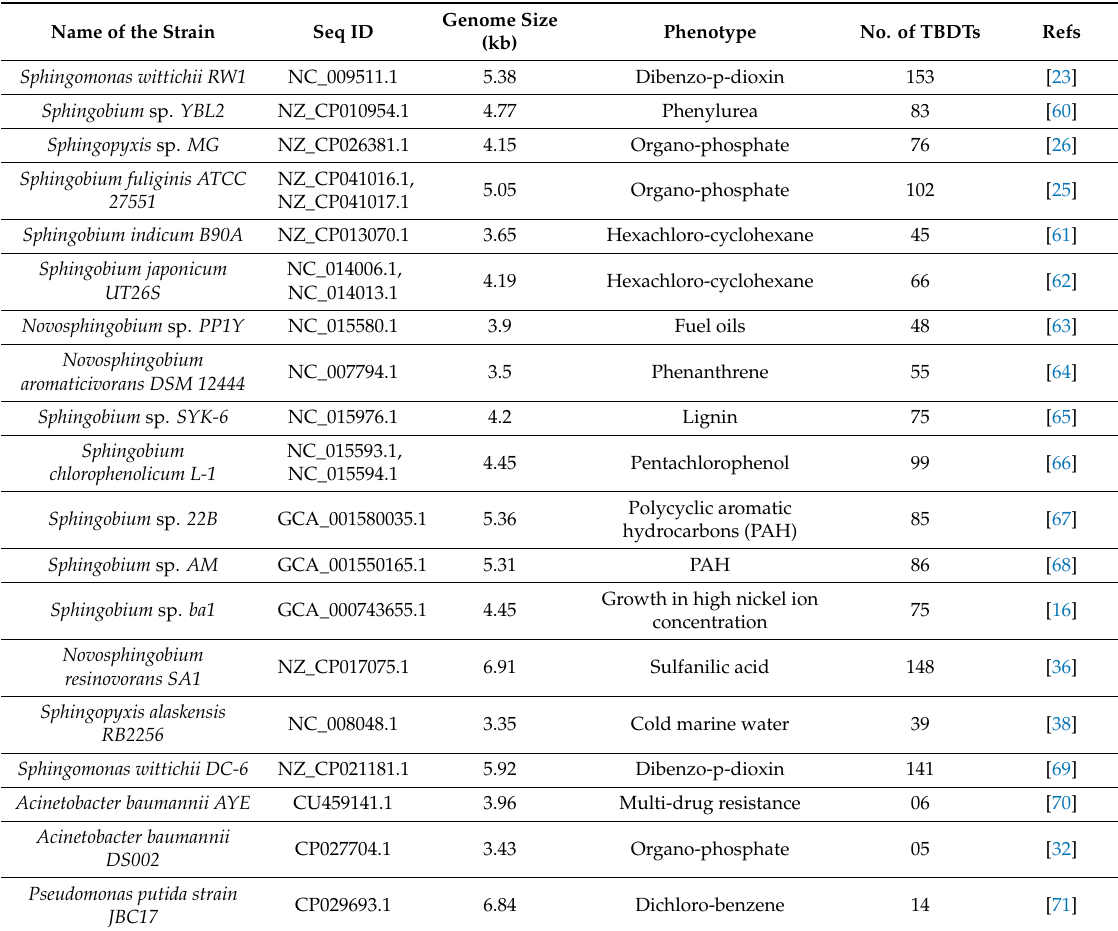
Table 2. Distribution of TBDTs in sphingomonads.